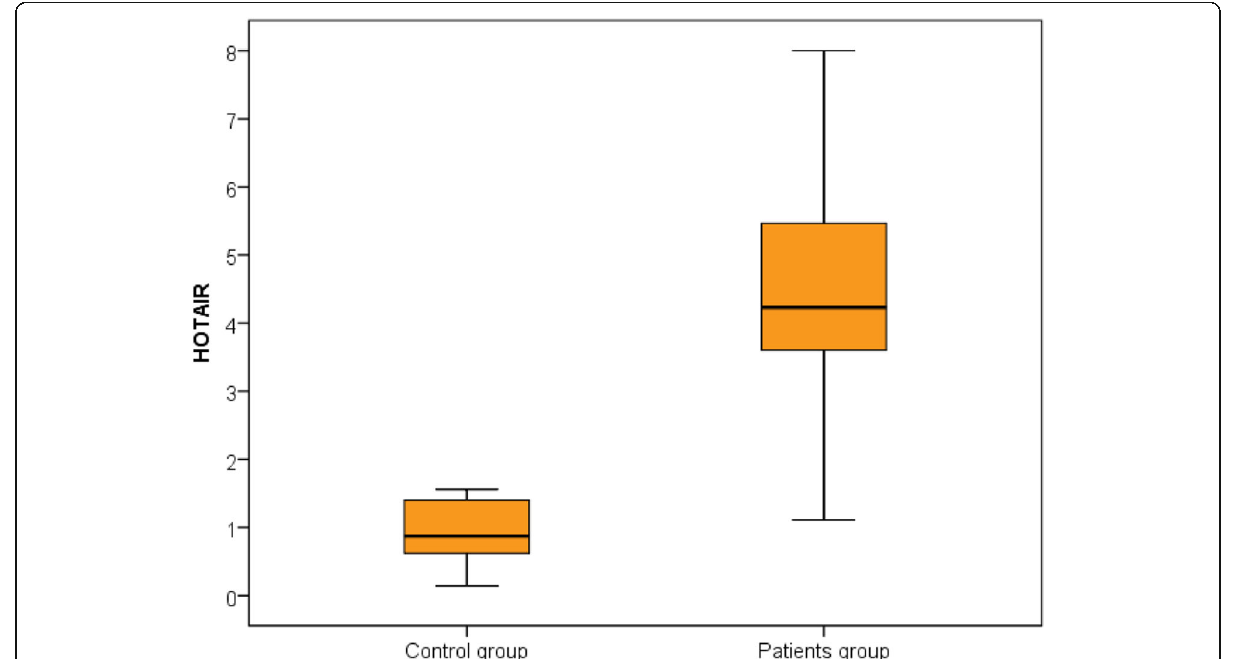
Fig. 2 Demonstration of difference of HOTAIR expression level between AML patients and control